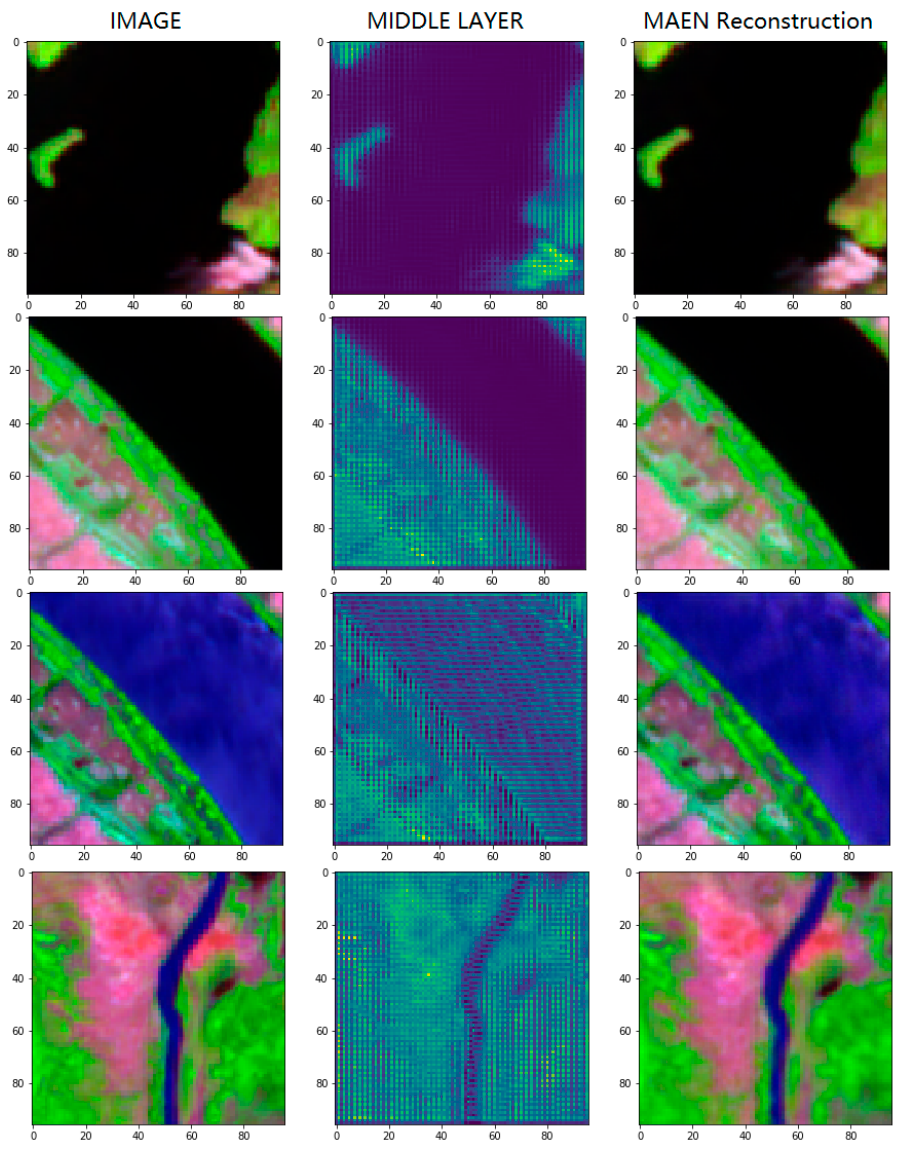
Figure 11. Figures of RSIR image visualization (column 1). Semantic features from the middle layer of the MAEN (column 2). MAEN image reconstruction (column 3) during the training process.